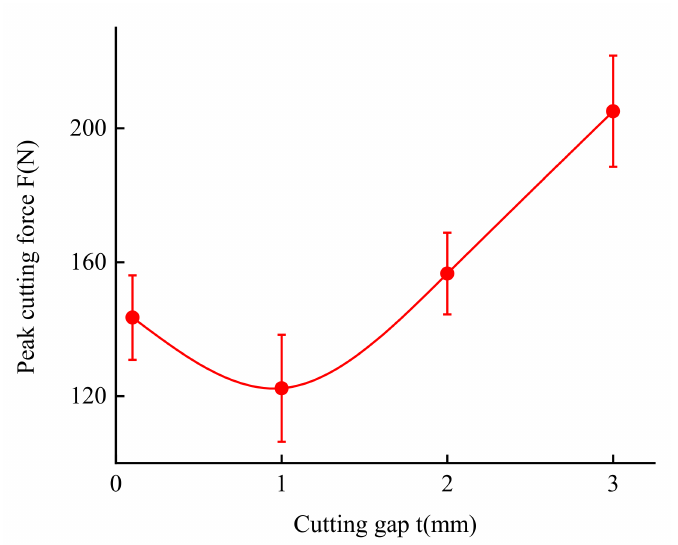
Figure 17. Relationship between cutting gap and peak cutting force. Note: branch diameter is 9–10 mm; wedge angle is 25 ◦ ; cutting speed is 3.36 m · s − 1 ; slip cutting angle is 20 ◦ ; cutting height is 5 cm; moisture content is 25.8%–28.2%.